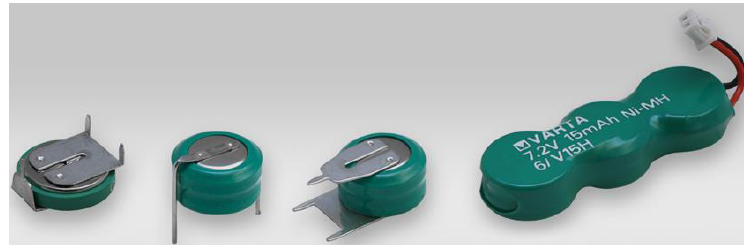
Figure 5. Button cells from Varta Microbattery [70].